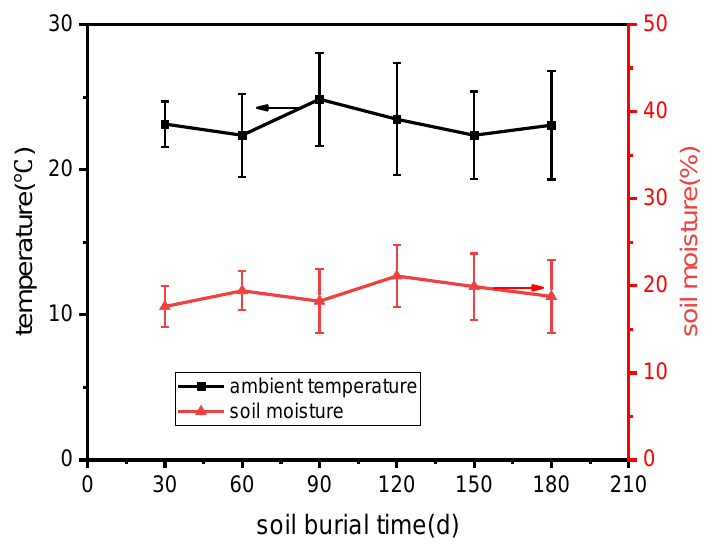
Figure 3. Average indoor temperature and soil moisture during soil degradation.